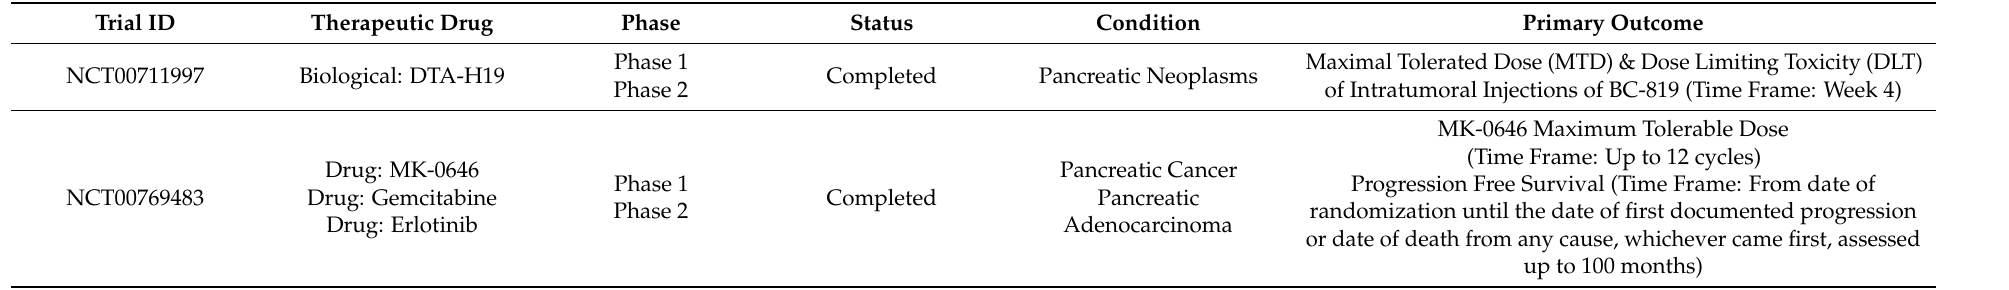
Table 3. Recent clinical trials based on gene therapy in human pancreatic